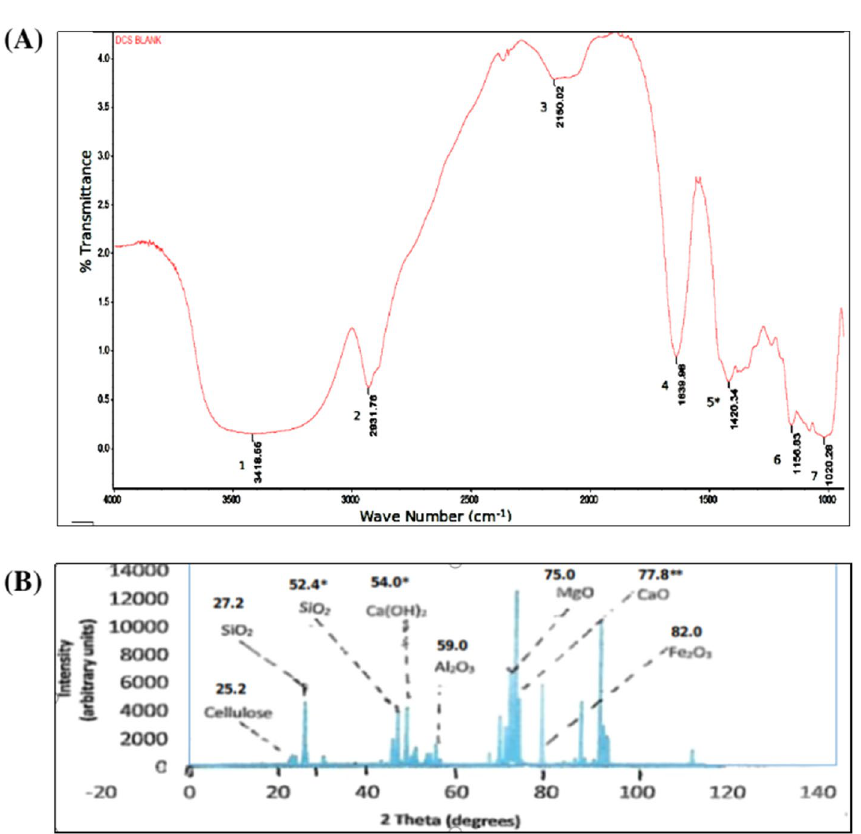
Figure 1. Spectroscopic characteristics of CDA: ( A ) Peak identification of FTIR spectrum of CDA used in this study as follows: 1 = 3419 cm −1 , –OH; 2 = 2918 cm −1 , –CH 2 –; 3 = 2150 cm −1 , –OH; 4 = 1638 cm −1 , C=O; 5 = 1420 cm −1 , –CH 2 – and C–O–O; 6–7 = 1157–1030 cm −1 , C–O–C, Si–O. *The sample was taken from CDA beads which contain alginate whose characteristic carboxylate –COO − function also absorbs in the 1420 cm −1 region. ( B ) Peak identification of XRD pattern shown by CDA. *These peaks were assigned to these minerals in the CDA sample studied by Vishwakarma and Ramachandran (see Ref. 45 ). **The sample was taken from CDA beads which contain Ca 2+ used for gelling the beads in our controlled release study (to be published) which is mainly responsible for the peak at 2 θ ° =